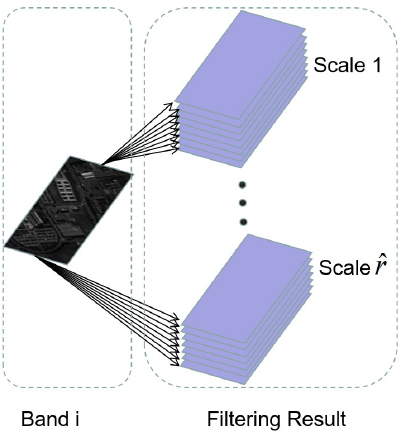
Figure 3. ( a ) The left and right side windows; ( b ) the up and down side windows; ( c ) the northwest, northeast, southwest, and southeast side windows.